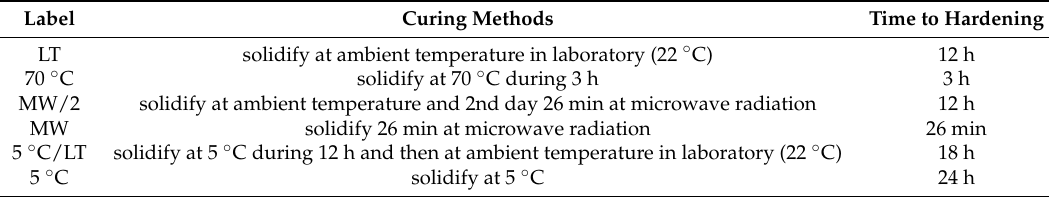
Table 3. Curing conditions of the